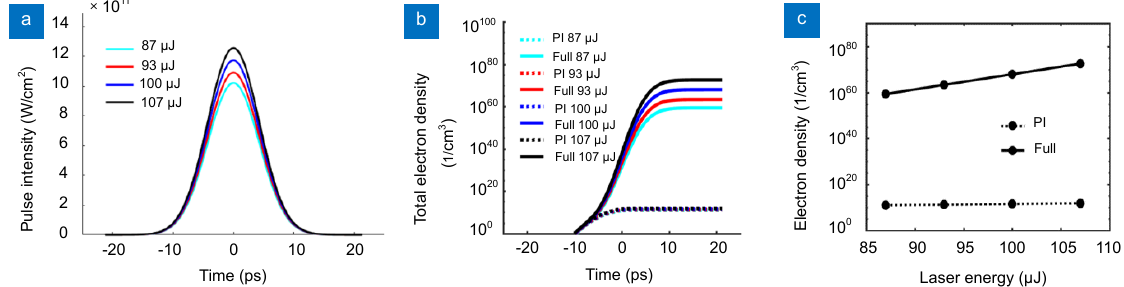
Fig. 2 | ( a ) Laser beam intensity profiles simulation for the energies 87 μ J, 93 μ J, 100 μ J and 107 μ J. ( b ) Simulation of the significant role ava- lanche plays after photoionization (PI) introduces “seed" electrons in sapphire when irradiated with different laser energies. ( c ) Full and PI electron densities as a function of laser